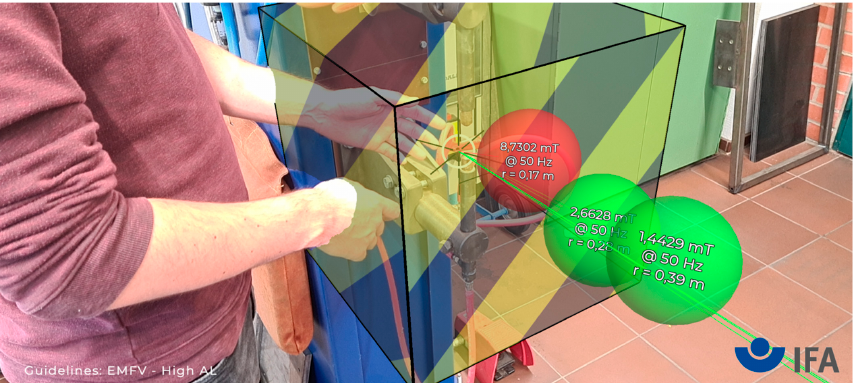
Figure 6. Twenty-eight of the thirty participants rated the AR visualization as either “helpful” or “very helpful” for improving the understanding of the exposure situation and the resulting safety distances.